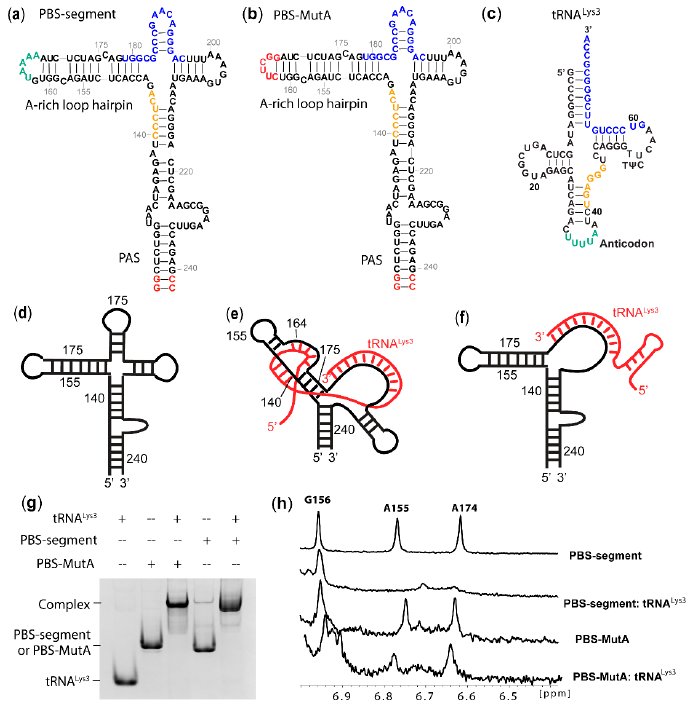
Figure 1. Mutation of the A-rich did not abolish tRNA Lys3 annealing but disrupted the possible A-rich loop: anticodon interactions. ( a ) Predicted secondary structure of protein binding site (PBS) segment RNA. The A-rich loop residues complementary to the anticodon of tRNA Lys3 are labeled in green, with additional complementary residues labeled in yellow. The 18-nt PBS is labeled in blue. Two non-native G-C pairs were added (red) to enhance the T7 transcription. ( b ) Predicted secondary structure of PBS-MutA, of which G162-A167 were substituted by CUUCGG (red). ( c ) Secondary structure of tRNA Lys3 . The 3 ′ -18-nt residues complementary to PBS are labeled in blue. Anticodon loop residues that are complementary to the PBS segment A-rich loop are labeled in green, with additional complementary residues labeled in yellow. ( d – f ) Cartoon models of the PBS segment (d), PBS segment: tRNA Lys3 complex with extended A-rich loop: anticodon intermolecular interactions (e), and without the extended interactions ( f ). The MAL PBS segment is labeled in black, and tRNA Lys3 is labeled in red. ( g ) Mutation of the A-rich loop did not prevent tRNA Lys3 annealing. Complex formation was examined using an 8% native PAGE. ( h ) Mutation of the A-rich loop disrupted the possible A-rich loop: anticodon interactions. Portion of 1D 1 H NMR of the PBS segment and PBS segment: tRNA Lys3 complexes (top) and PBS-MutA and tRNA Lys3 complexes (bottom). The signal-to-noise of the PBS-MutA samples were lower, because the RNA sample concentrations used for NMR data collection were lower than the wild-type (WT) RNAs.